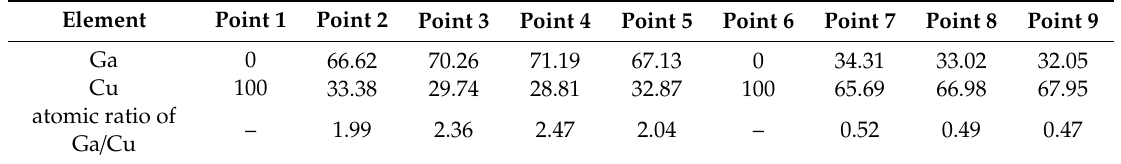
Table 1. The EDS analysis results of di ff erent points in Figure 5.